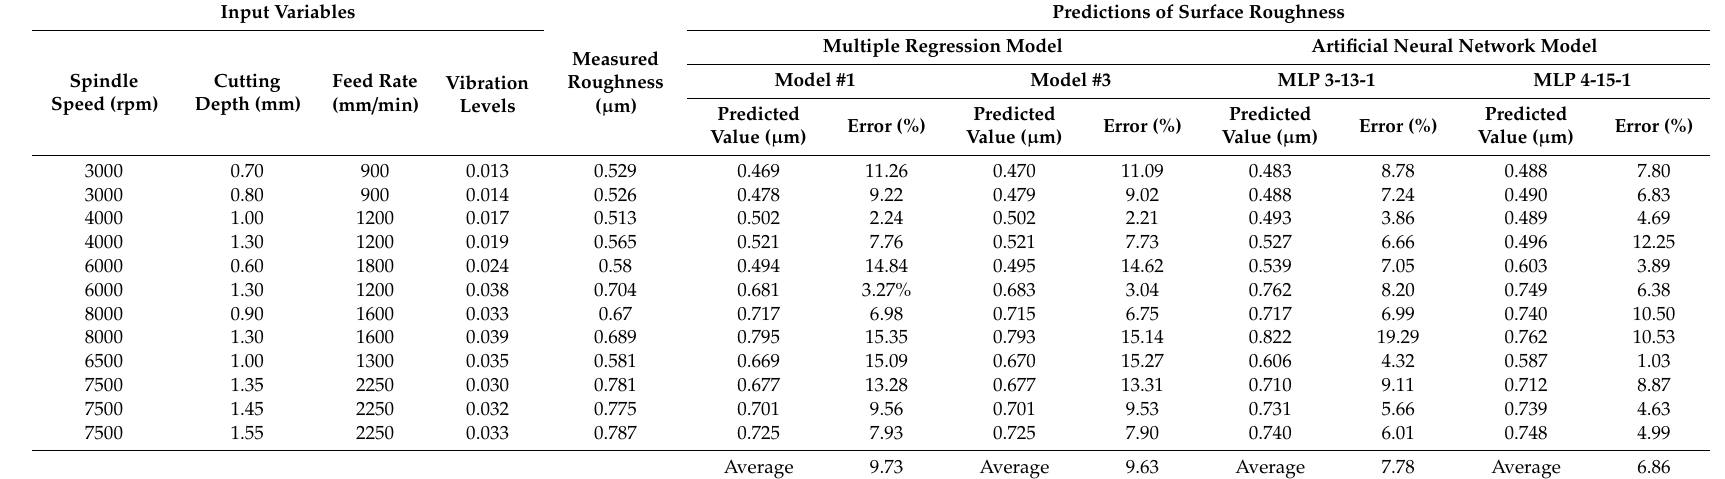
Table 7. Details of the cutting parameters, measured surface roughness, and predicted values for model